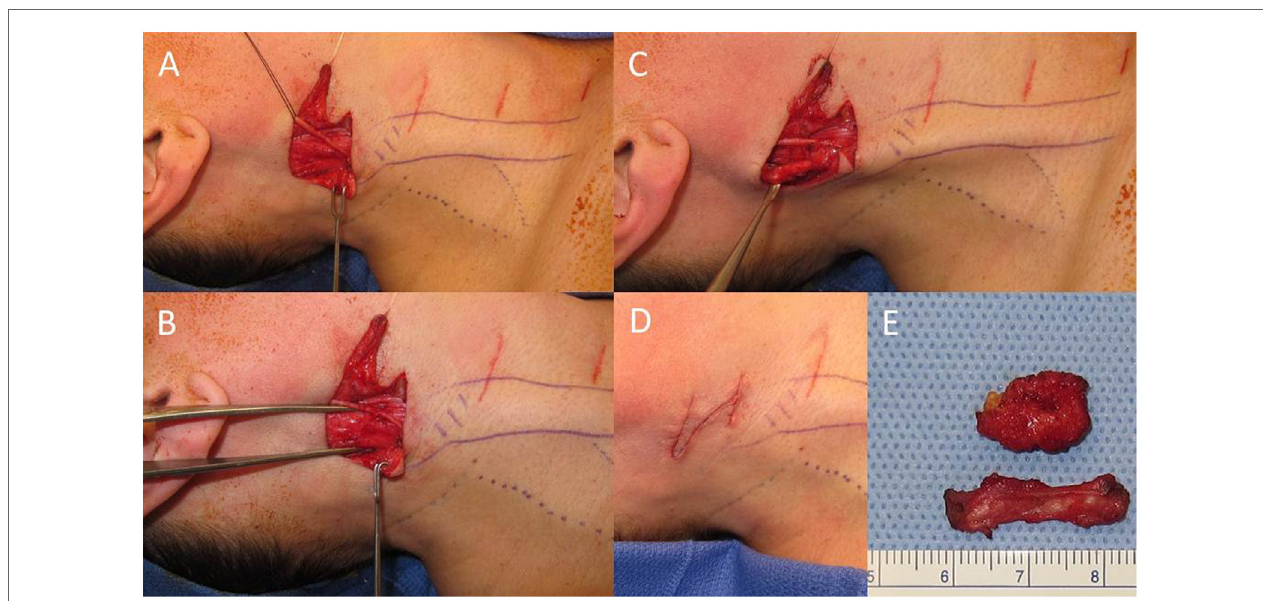
FIGURe 3 | Intraoperative images and fibrotic band. Initial dissection with isolation and neurolysis of the great auricular nerve indicated by the black suture (a) . Right sternocleidomastoid (SCM) indicated by the forceps (B) . Fibrotic band within the SCM (C) . Closure of Z-plasty incision (D) after resection of fibrotic band and remnant SCM (e)